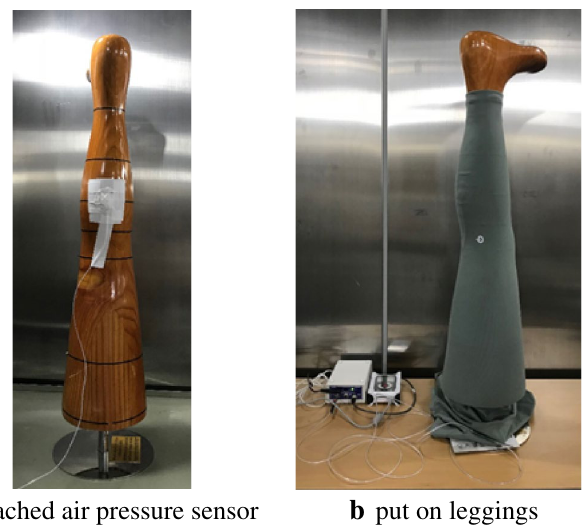
Fig. 2 Leg model for standard pressure setting and measurement of medical compression stocking (Korea Patent No.10-, 1524019-0000,